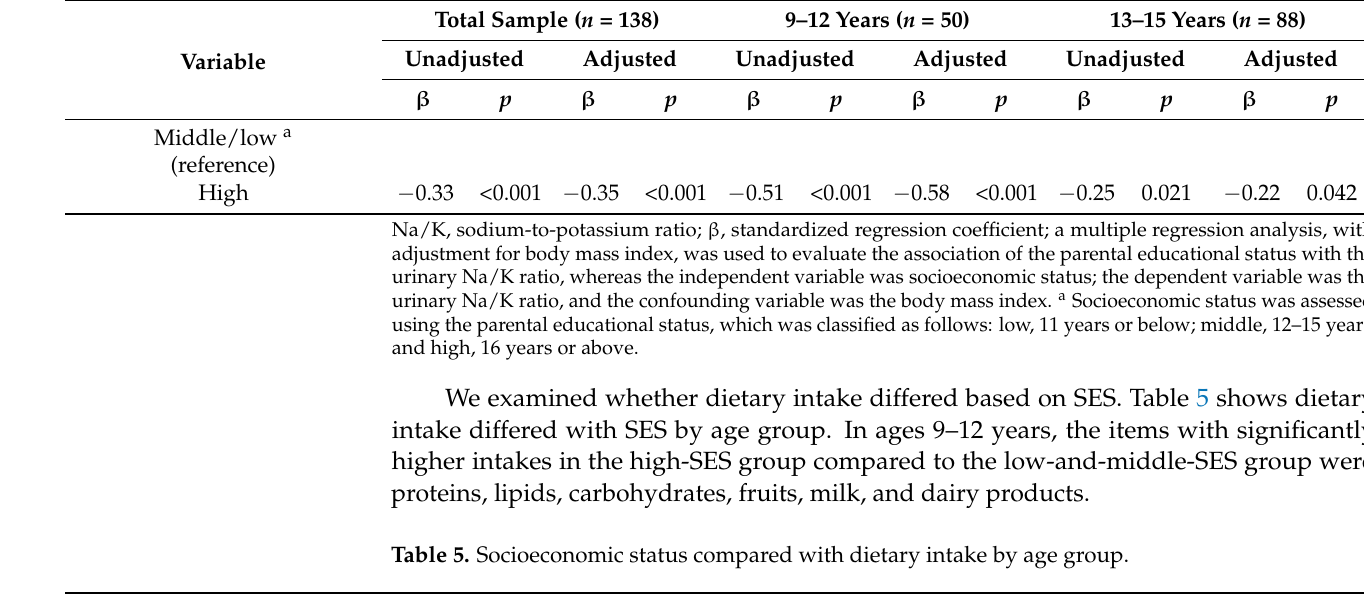
Table 4. Associations between the socioeconomic status and the urinary Na/K ratio by age group.